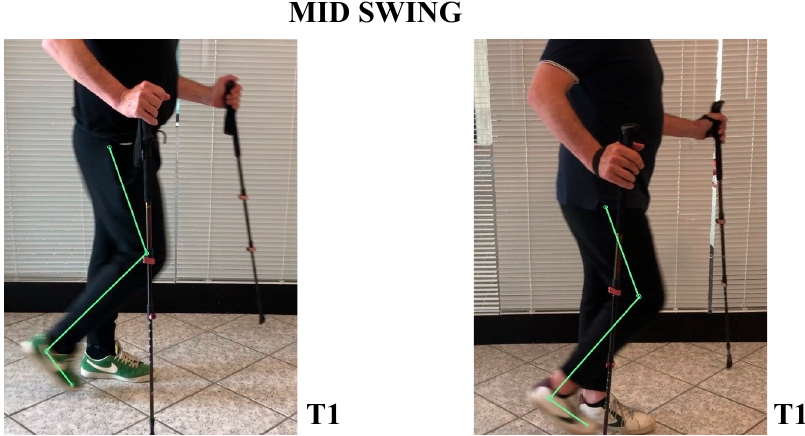
Figure 7. Pre-swing frames; with RAGT training, the patient became able to align foot-knee hip axis, thus allowing a greater propulsion to beginning step.